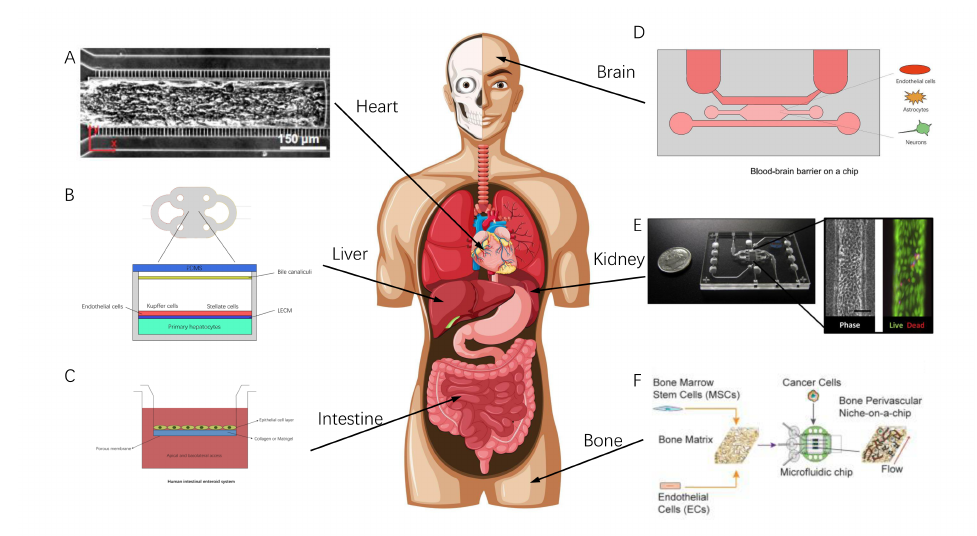
Figure 2. Some of the OOCs that have been developed for corresponding organs of the human body. ( A ) Cardiac MPS from UC Berkeley Healy Lab (adapted and modified from [25]). ( B ) The Liver Acinus MicroPhysiology System. ( C ) Intestine-on-a-chip. ( D ) Schematic of the human-neurovascular- unit-on-a-chip with a functional blood–brain barrier. ( E ) Kidney Proximal Tubule MPS (adapted and modified from [28]). ( F ) Schematic diagram of the preparation of the bone perivascular (BoPV) niche (adapted and modified from